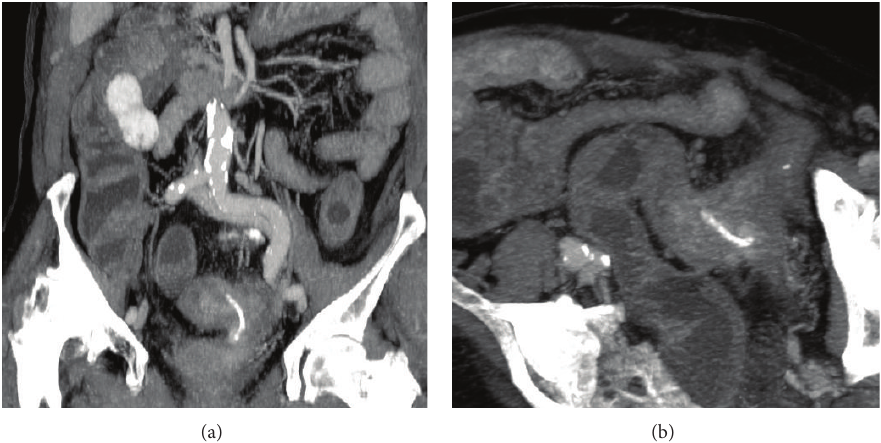
Figure 2: CT MPR images after contrast medium administration in portal (a) and delayed phase (b) showing the curvilinear sharp-pointed foreign body in the sigma and the contrast-enhancement within the inflammatory pseudotumoral mass at the FB